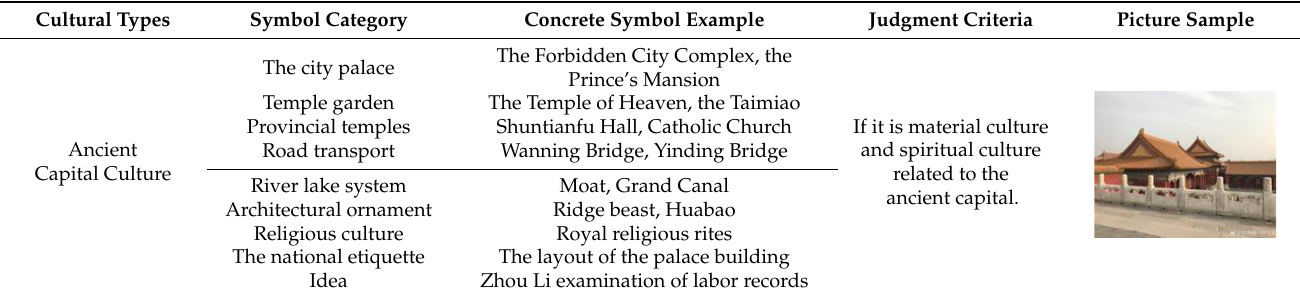
Figure 2. Study framework. Table 1. Cultural perception symbol system. Table 1. Cultural perception symbol